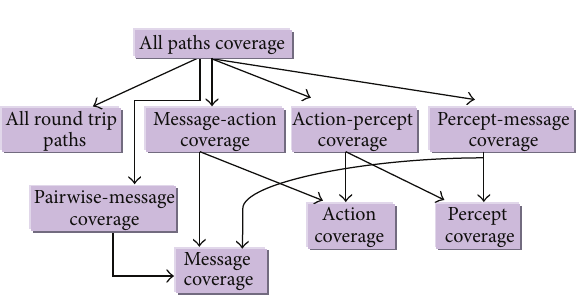
Figure 4: Test Coverage Criteria